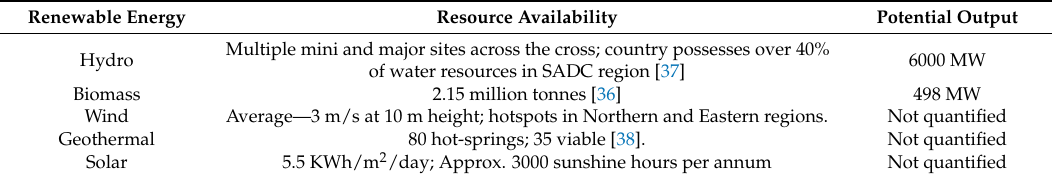
Table 2. Information contained in the Table above was mostly extracted from the Renewable Readiness Country Assessment. Other sources are as